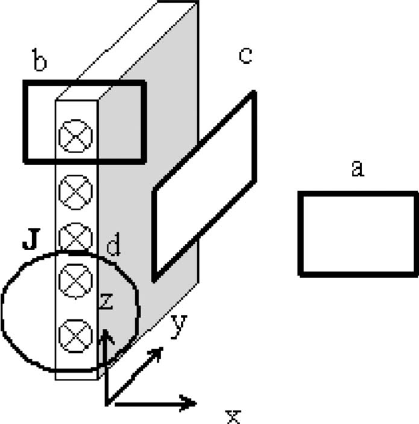
FIG. 4. The post-Ampère’s law tutorial question: We have a large (cid:1) infinite (cid:2) sheet with a uniform current density J flowing down it. The current runs in the + y direction, as shown. (cid:1) The sheet is infinite in the y and z directions. (cid:2) Consider several small Ampèrian loop choices, labeled a-d. List ALL of these which might prove useful in learning something quantitative about B (cid:1) x , y , z (cid:2) some- where . For each loop, explain briefly why you did NOT choose it if you didn’t, or what it’s useful for if you